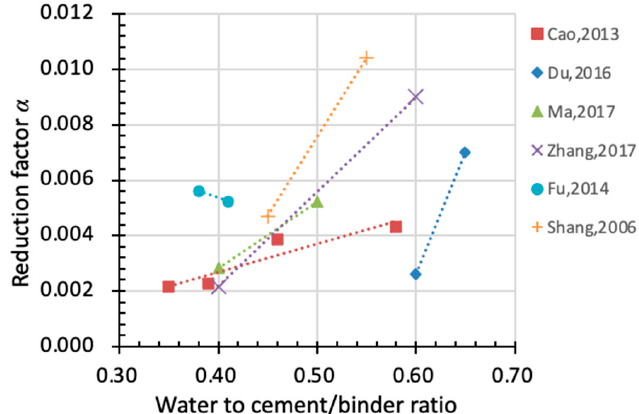
Figure 19. Relationship between w / c ratio and reduction factor α (x-axis: water to cement ratio, y- axis: factor α ).